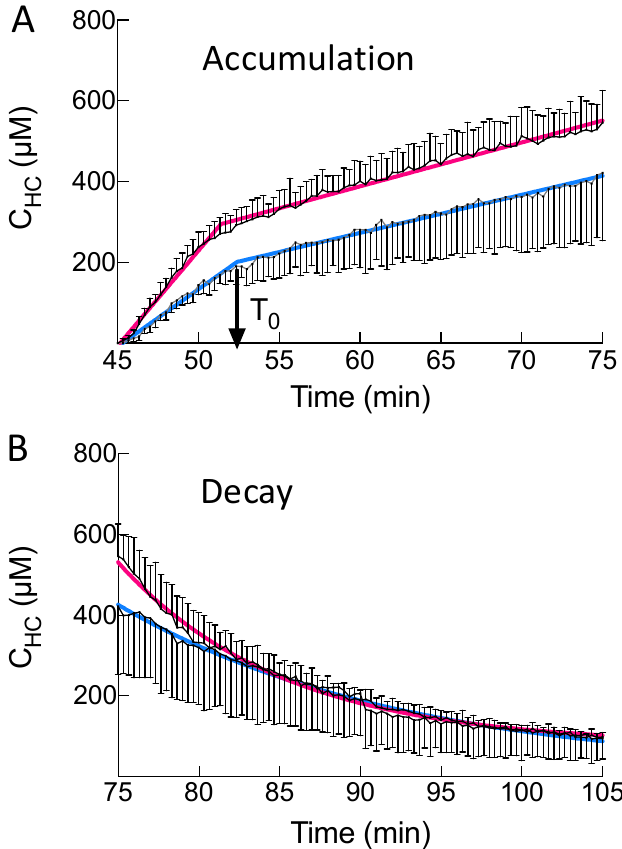
Figure 5. ( A ) Accumulation of BOPTA hepatocyte concentrations from 45 to 75 min. Accumulation was best described by a segmental linear regression (red curve for normal livers and blue curve for MCT livers. T 0 (black arrows) was the time when BOPTA cellular efflux started to decrease hepatocyte concentrations. T 0 was similar in both groups. ( B ) BOPTA concentration decay during the rinse period from 75 to 105 min, when livers were perfused only with the Krebs–Henseleit bicarbonate solution. Hepatocyte decay was best described by a one-phase decay (red curve for normal livers and blue curve for MCT livers).